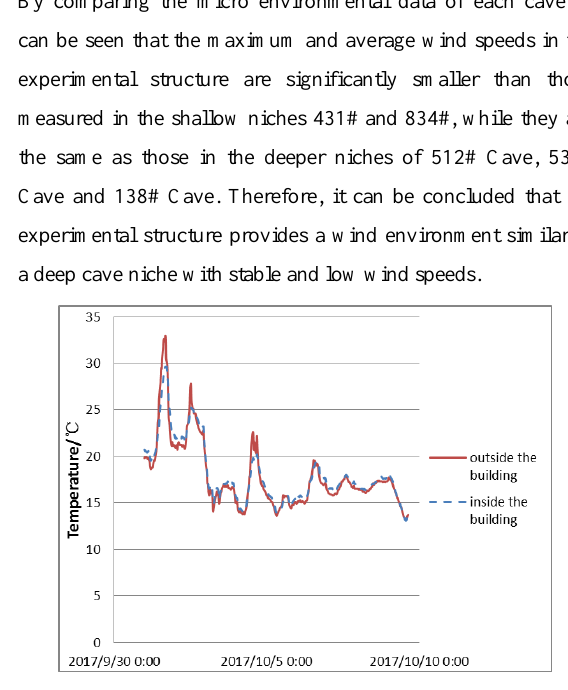
Figure 2 Comparison of temperature of microenvironment inside and outside the experimental